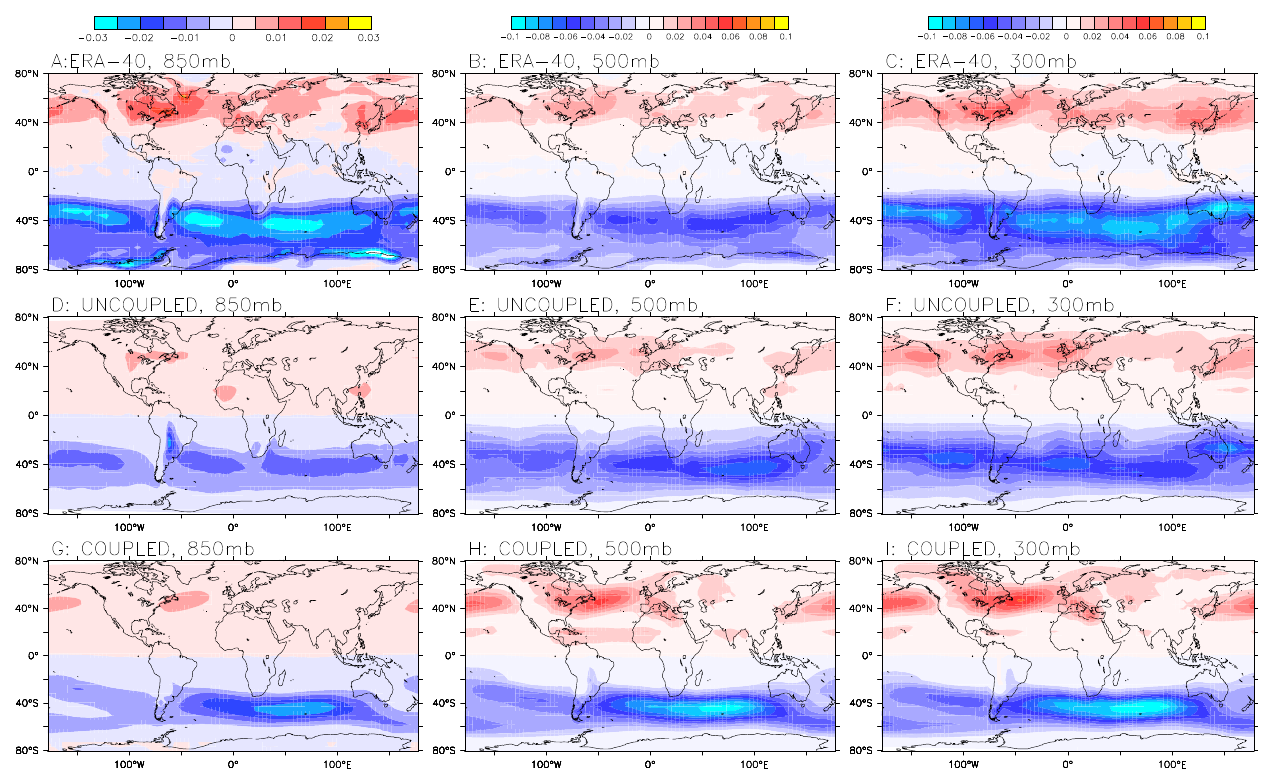
Fig. 8. Band-pass filtered ERA-40 data at (a) 850mb, (b) 500mb and (c) 300mb of h v 0 w 0 i (in m 2 s − 2 ) for June-July-August. (d–f) show results of “uncoupled” and (g–i) “coupled” experiments using Aeolus (Eq. 7) at same pressure